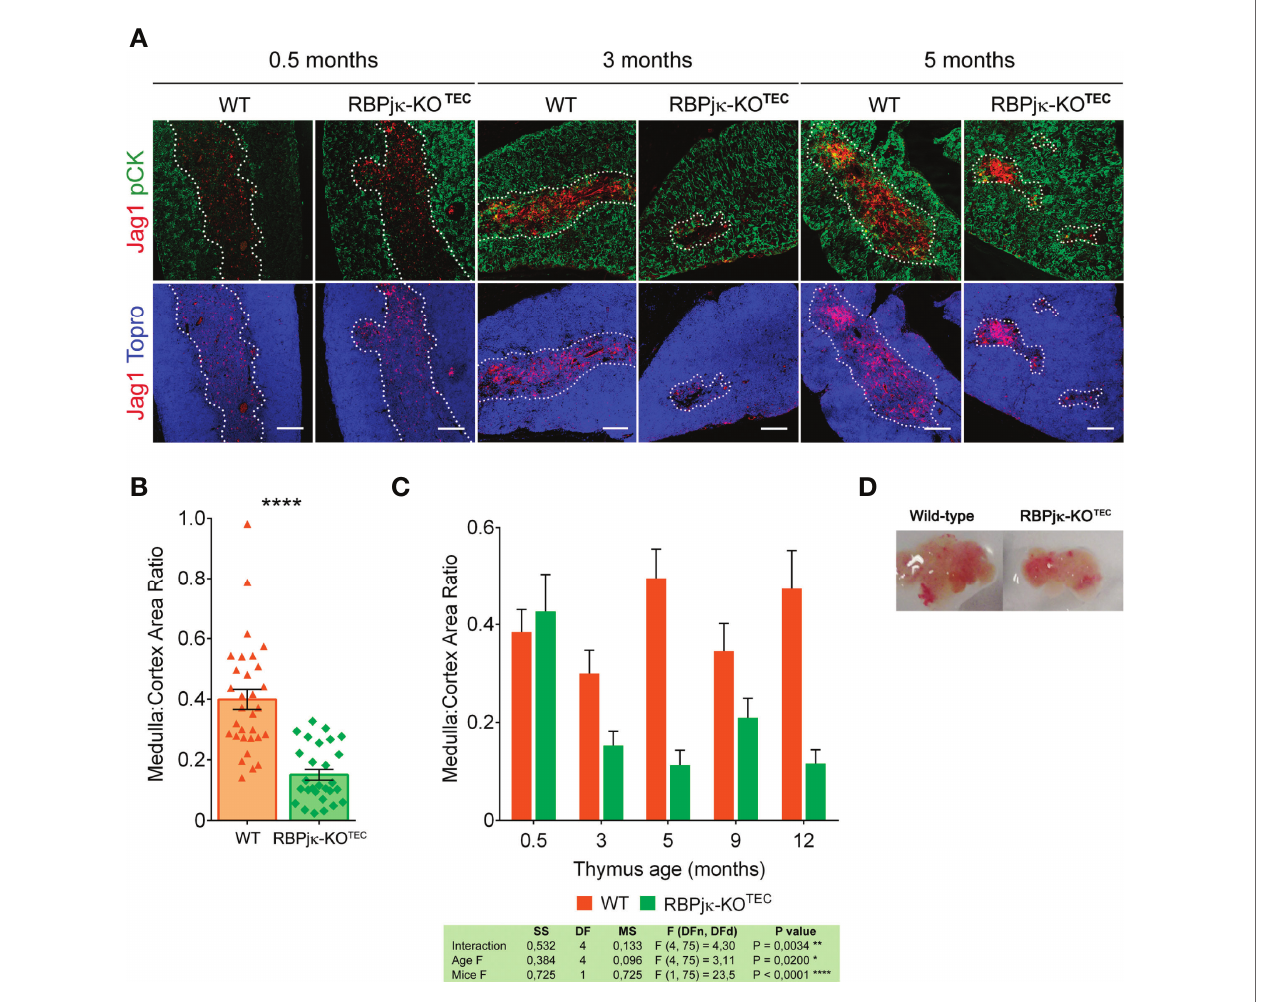
FIGURE 6 | Abrogation of Notch signaling in TECs results in thymic medulla disruption and thymus atrophy. (A) Immunohistochemistry of thymi from mutant RBPj k – KO TEC and WT Foxn1 +/+ x RBPjk fl / fl littermate mice at 0.5-, 3- and 5-months of age. TECs are characterized by expression of pCK (green), Jag1 Notch ligand (red) expression marks medullary TECs, and Topro3 shows nuclear staining (blue). Images are representative of n ≥ 10 images per sample (n ≥ 3 thymus samples per age). Scale bar: 200 m m. (B) Ratio of medulla: cortex area measurements derived from histomorphometric analysis ( Supplementary Figure 4 ) of postnatal